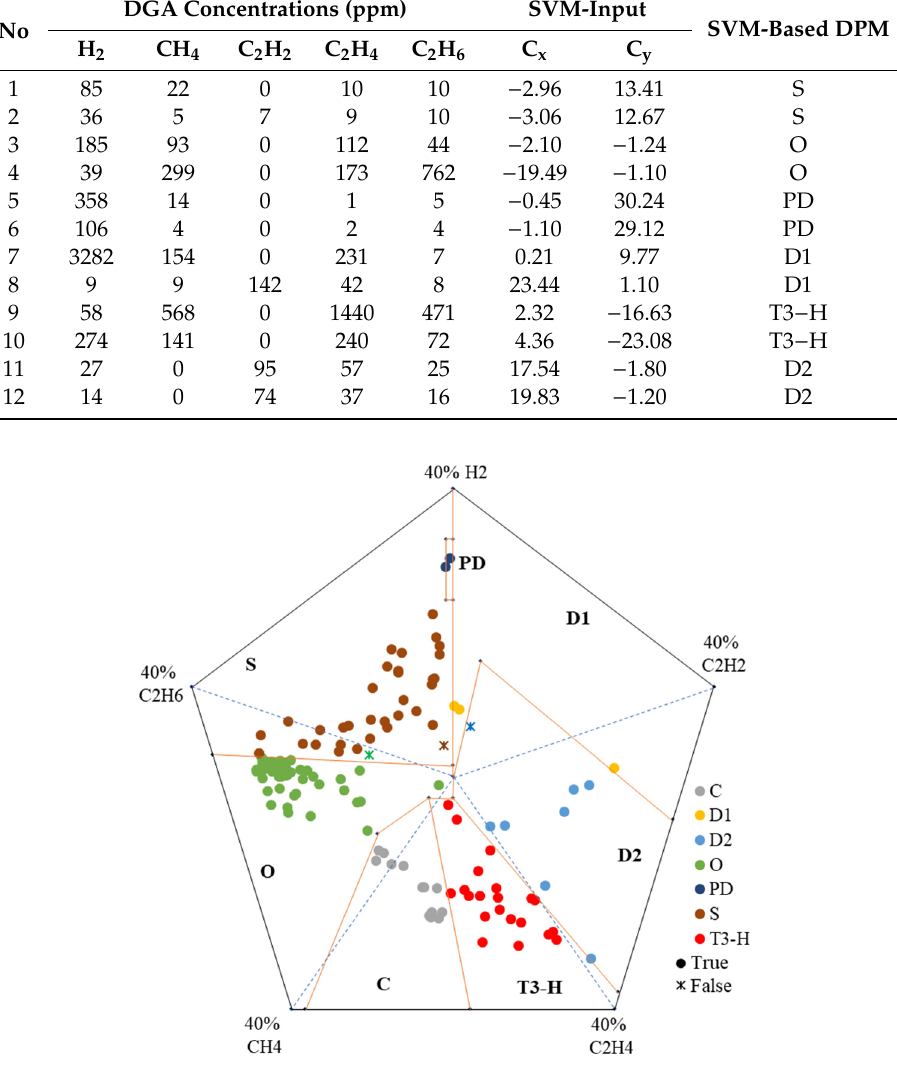
Figure 4. Prediction results of SVM-based DPM.